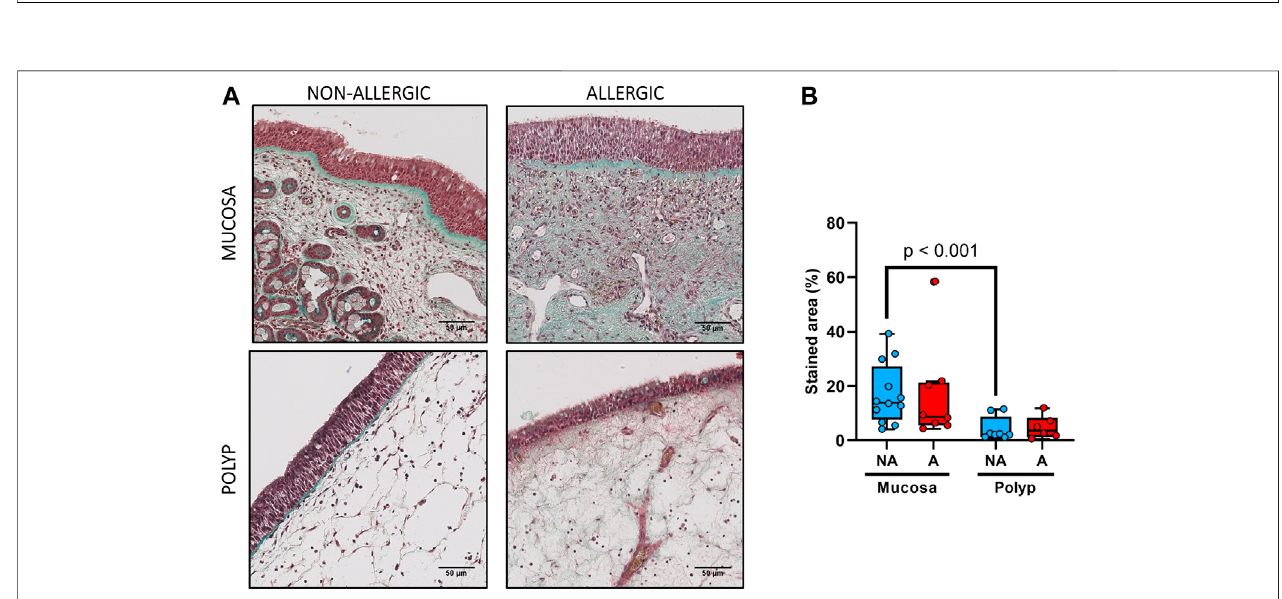
FIGURE 6 | Analysis of collagen fi bers deposition in nasal polyps and nasal mucosa. (A). Representative images of Masson-Trichrome staining in nasal mucosa ( n (cid:2) 20) and nasal polyps ( n (cid:2) 14) in all experimental groups (collagen fi bers: green, cytoplasm: red, erythrocytes: gold, scale bar (cid:2) 50 μ m). (B). Comparison of the green-stained area (collagen fi bers) in nasal polyps and nasal mucosa samples between non-allergic CRSwNP (NA) and allergic CRSwNP (A) patients. Results are presented as mean ± SEM. Mann-Whitney U test was used to state signi fi cant differences.